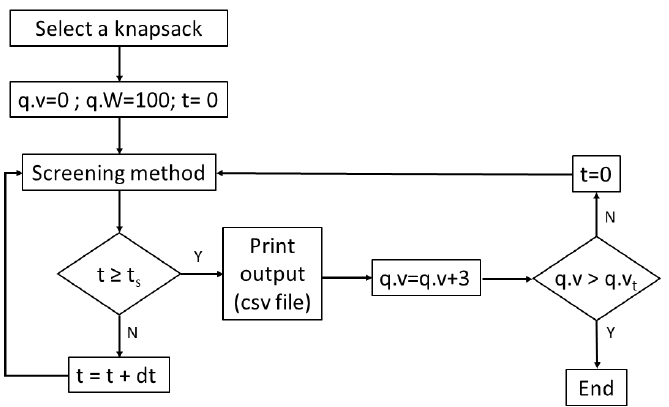
Figure 6. Bacterial chemotaxis. ( A ) When the S signal is present in the medium, S binds to the MCP (methyl-accepting chemotaxis proteins) receptor leading to CheY phosphorylation (CheY-P). Following, CheY-P will bind with the engine’s FliM protein, resulting in the clockwise (CW) motor rotation, which causes a random movement of the bacteria or bacterial ‘tumbling’. ( B ) On the other hand, in the absence of the S signal, CheY is defosphorylated, leading to the counterclockwise (CCW) motor rotation and therefore, the bacterium moves in a straight direction or ‘swimming’.